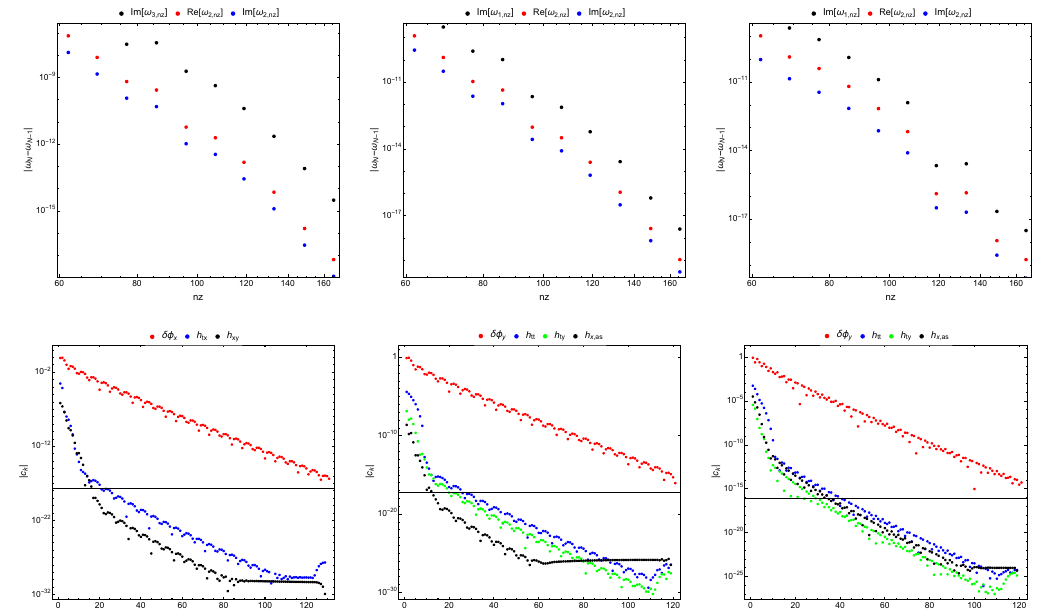
Figure 27 . Top panel: moving of the eigenvalues; monitored is the di(cid:11)erence of the absolute value of the eigenvalues with increasing gridsize of the lowest QNMs. The di(cid:11)erence decreases with higher grid resolutions. The plots correspond to the transverse sector of the V ( Z ) model, the longitudinal sector of the V ( Z ) model and the longitudinal sector of the V ( X ) model (from left to right). Bottom panel: Chebychev coe(cid:14)cients of the eigenfunctions of the lowest QNM. where x = f (cid:14)(cid:30) ; h ; h g in the transversal cases and x = f (cid:14)(cid:30) x tx xy tudinal cases, respectively. We may solve this equation by solving the generalized eigenvalue problem, where the unknown functions are the eigenfunctions and the quasinormal modes ! are the eigenvalues of the matrix equation n